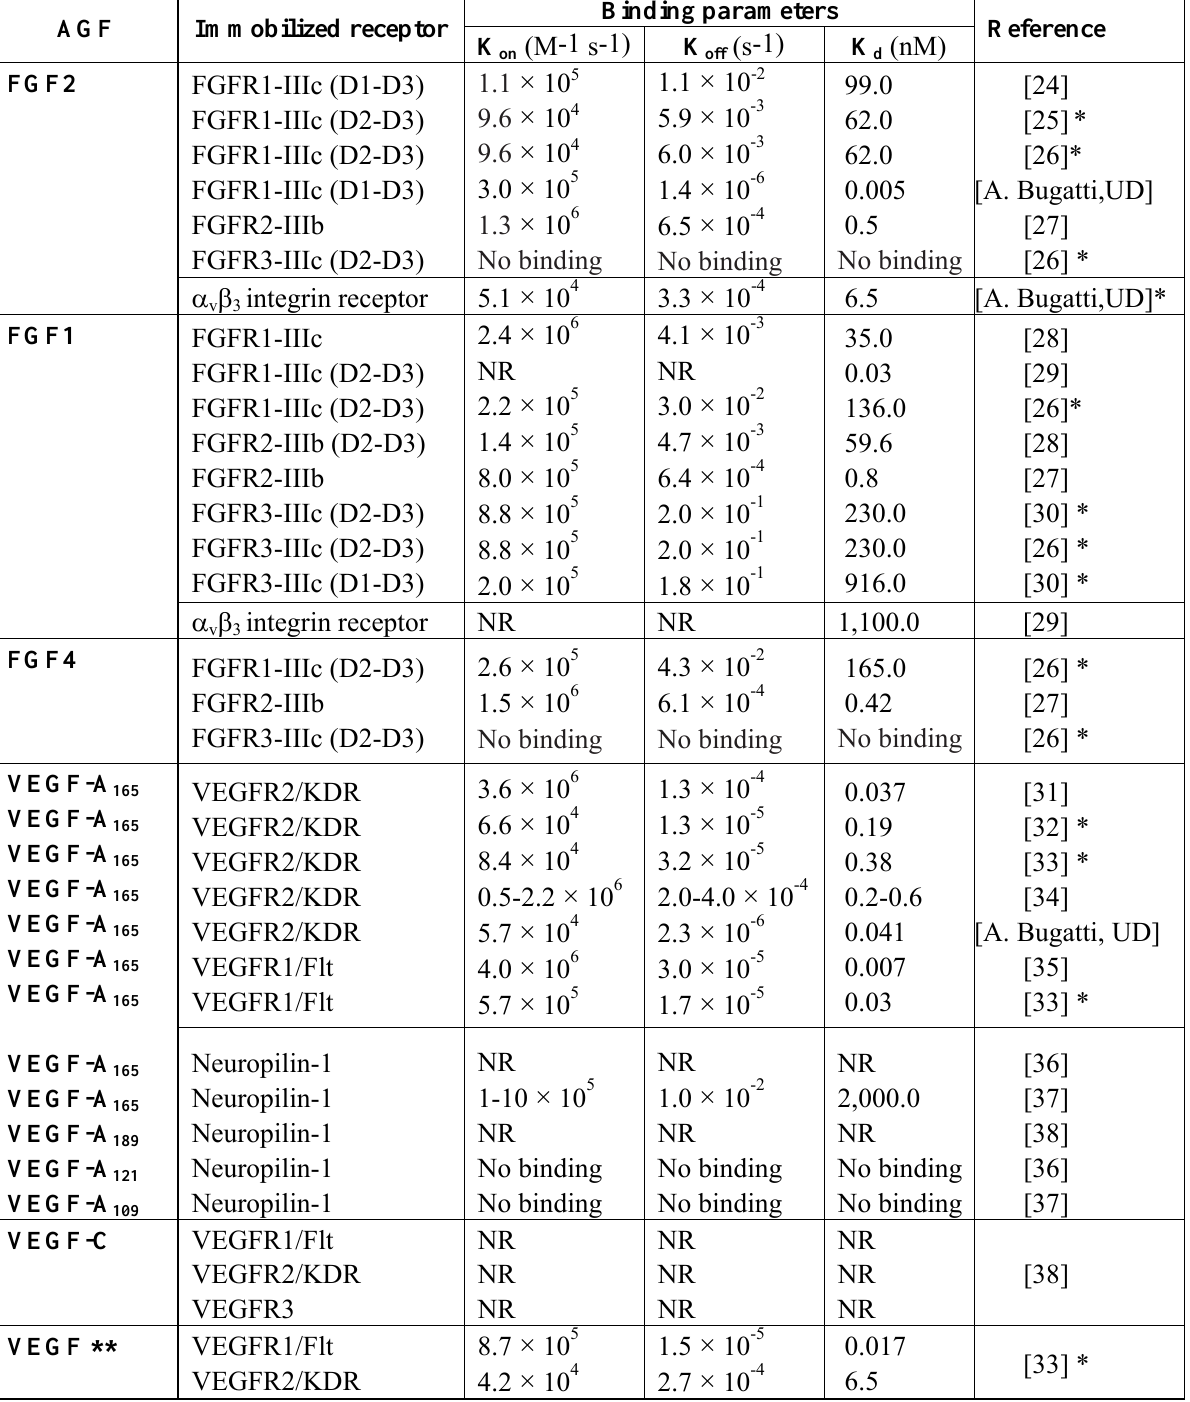
Table 1. SPR analysis of the interaction of AGFs with their signalling receptors . SPR was used to assess the kinetics of interaction between the free AGF (analyte) and the extracellular domain of the cognate signalling receptor immobilized to the sensor chip